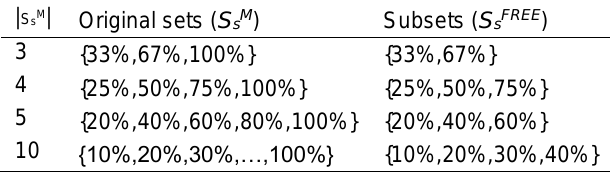
Table 1. Sets of MLD control levels considered